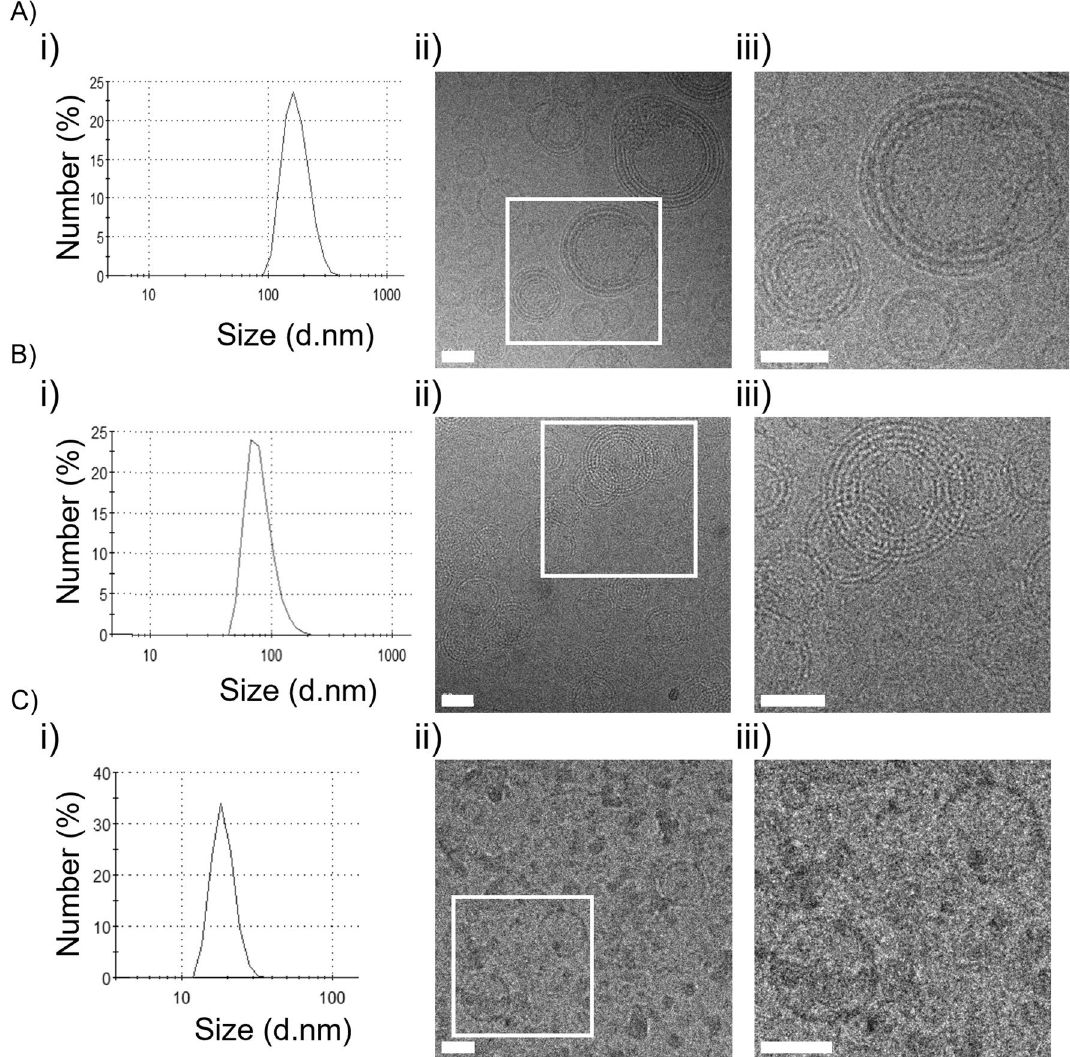
Figure 2. Size distribution and Cryo-TEM observation of NLS-(− 30)GFP-LNP formulations. ( A ) NLS-(− 30) GFP-LNPs (1:10), ( B ) NLS-(− 30)GFP-LNPs (1:50) and ( C ) LNPs formed without using NLS-(− 30)GFP [LNPs (no NLS-(− 30)GFP)]. (i) Size distribution of NLS-(− 30)GFP-LNPs analyzed using DLS. (ii) The morphology of NLS-(− 30)GFP-LNPs was observed via Cryo-TEM technology. (iii) The magnified image of (ii). Scale bars 50